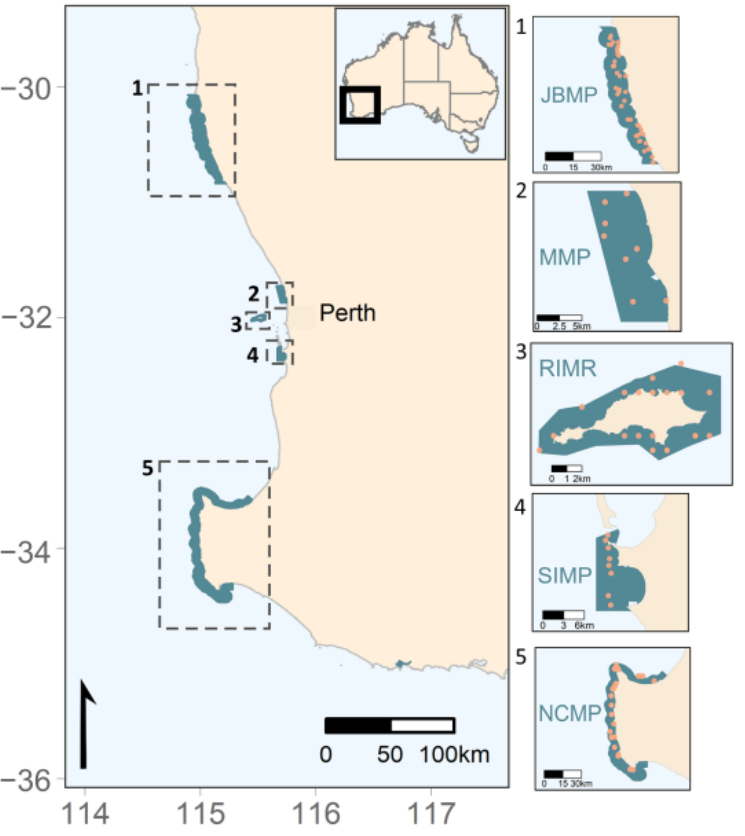
Figure 1. Coral survey sites (orange dots) at sub-tropical and temperate marine parks in Australia’s south-west region. (1) Jurien Bay Marine Park (JBMP), (2) Marmion Marine Park (MMP), (3) Rottnest Island Marine Reserve (RIMR), (4) Shoalwater Islands Marine Park (SIMP), and (5) Ngari Capes Marine Park (NCMP).